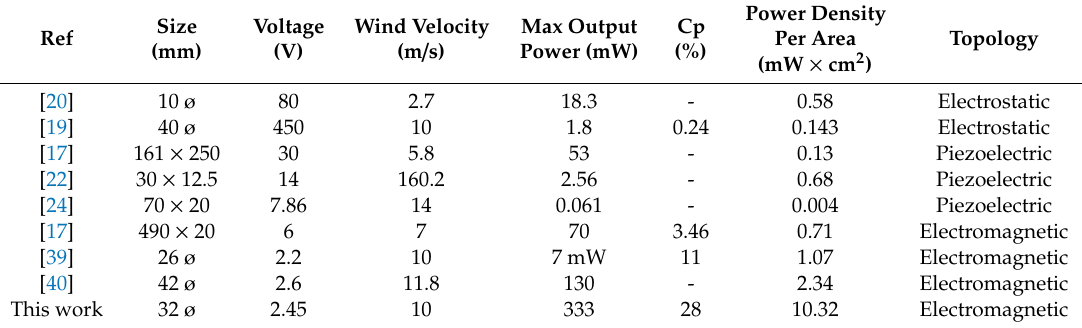
Table 13. Comparison of the performances of wind energy